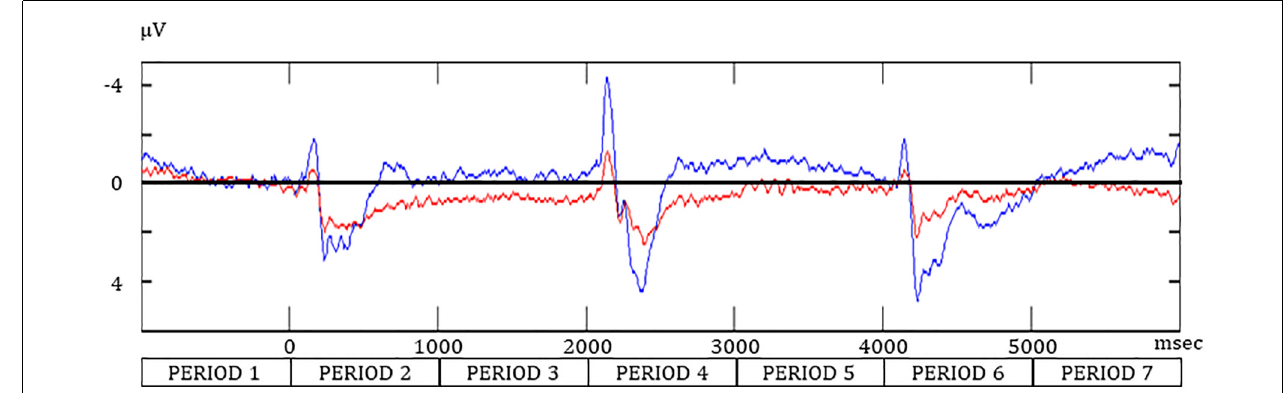
FIGURE 3 | The event-related potential at Oz during the SR and WM tasks. Redline, the “Match” condition during the SR task; navy line, the “Go” condition in the WM task.